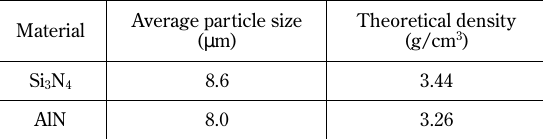
Table 2 Average diameter size and theoretical density of the matrix and reinforcement powders.